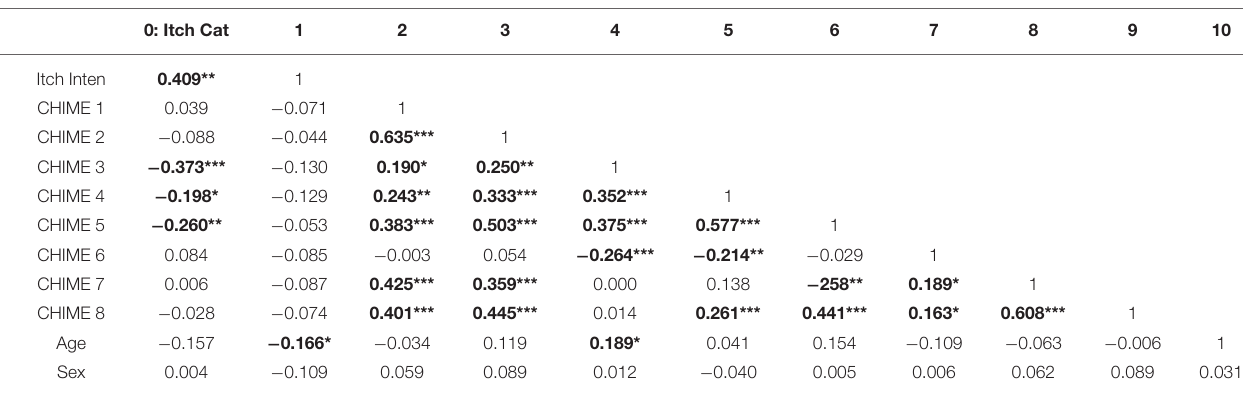
TABLE 2 | Results of the correlation